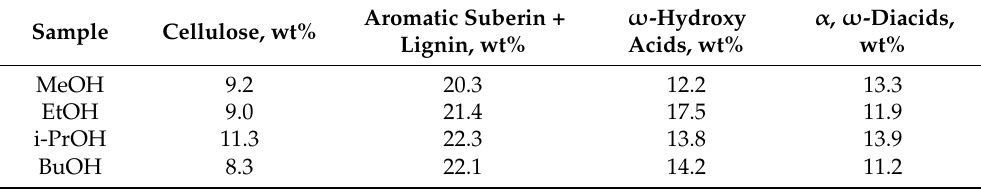
Table 6. Estimations of chemical composition (dry-basis) of adhesive samples from TGA analysis.